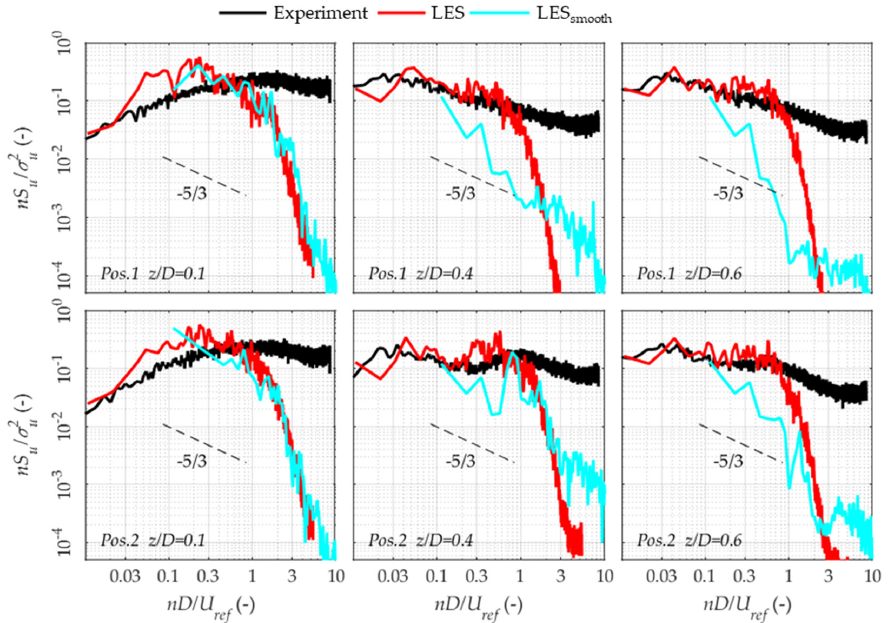
Figure 12. Power spectral density for position 1 and position 2 at two heights, z/D = 0.1 and 0.6.